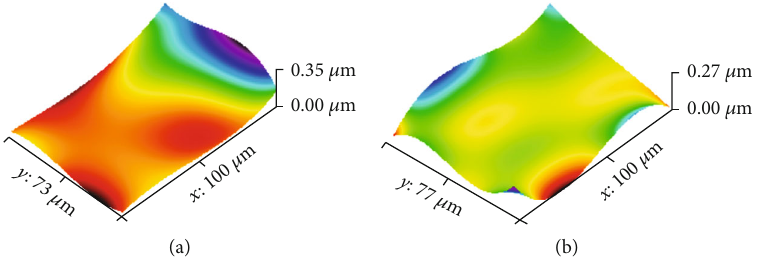
Figure 5: 3D background plot of aerosols: (a) bioaerosols and (b) chem-aerosols.